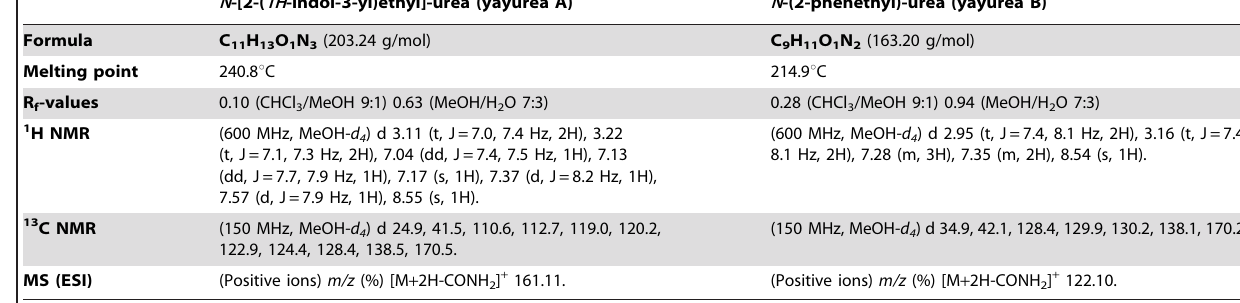
Table 1. Physical data for yayurea A and B.